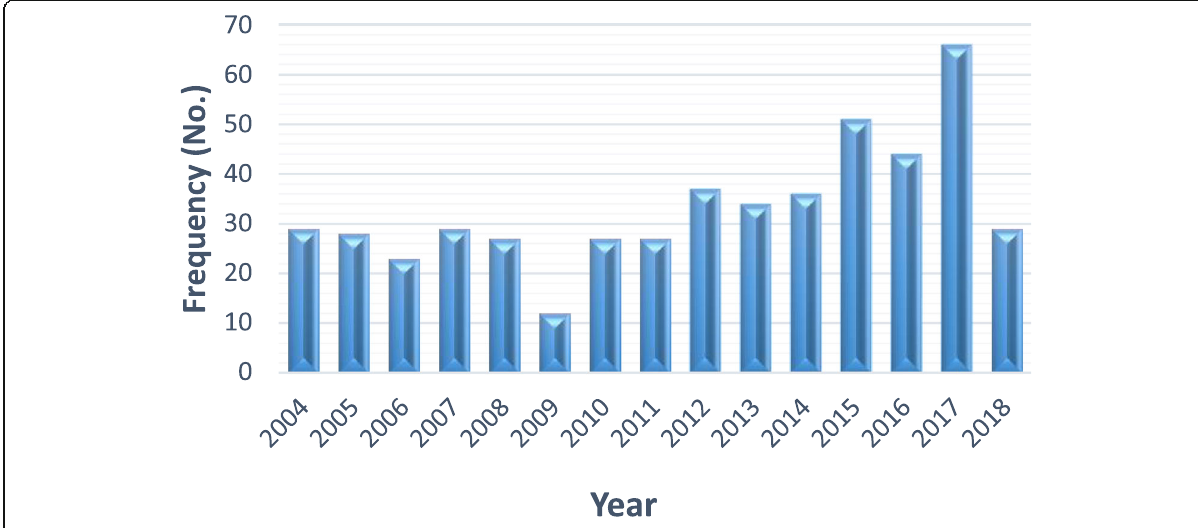
Fig. 1 Frequency of CE cases per year, during 2004 – 2018 in Fars province, southwest Iran